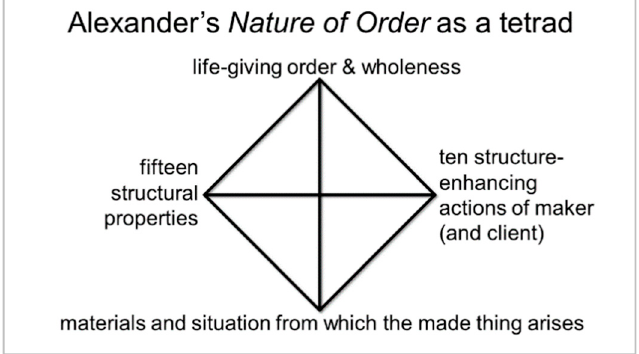
Figure 5. Alexander’s Nature of Order as a tetrad.